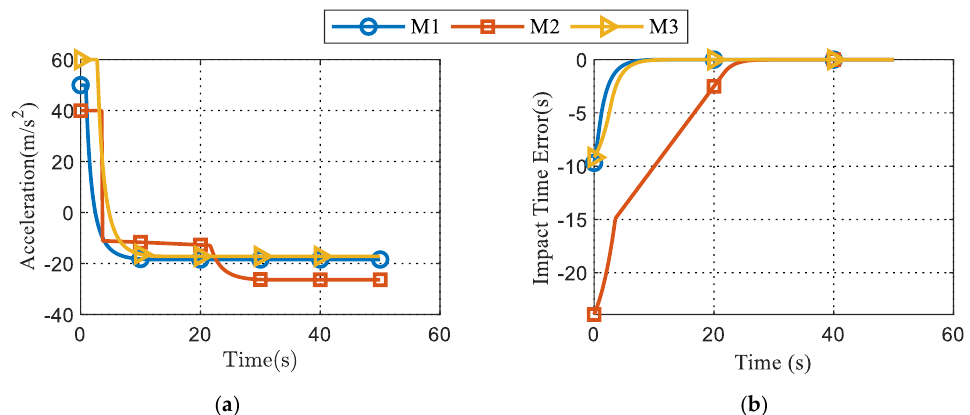
Figure 14. The results in a salvo attack. ( a ) Lateral accelerations; ( b ) Impact time errors.